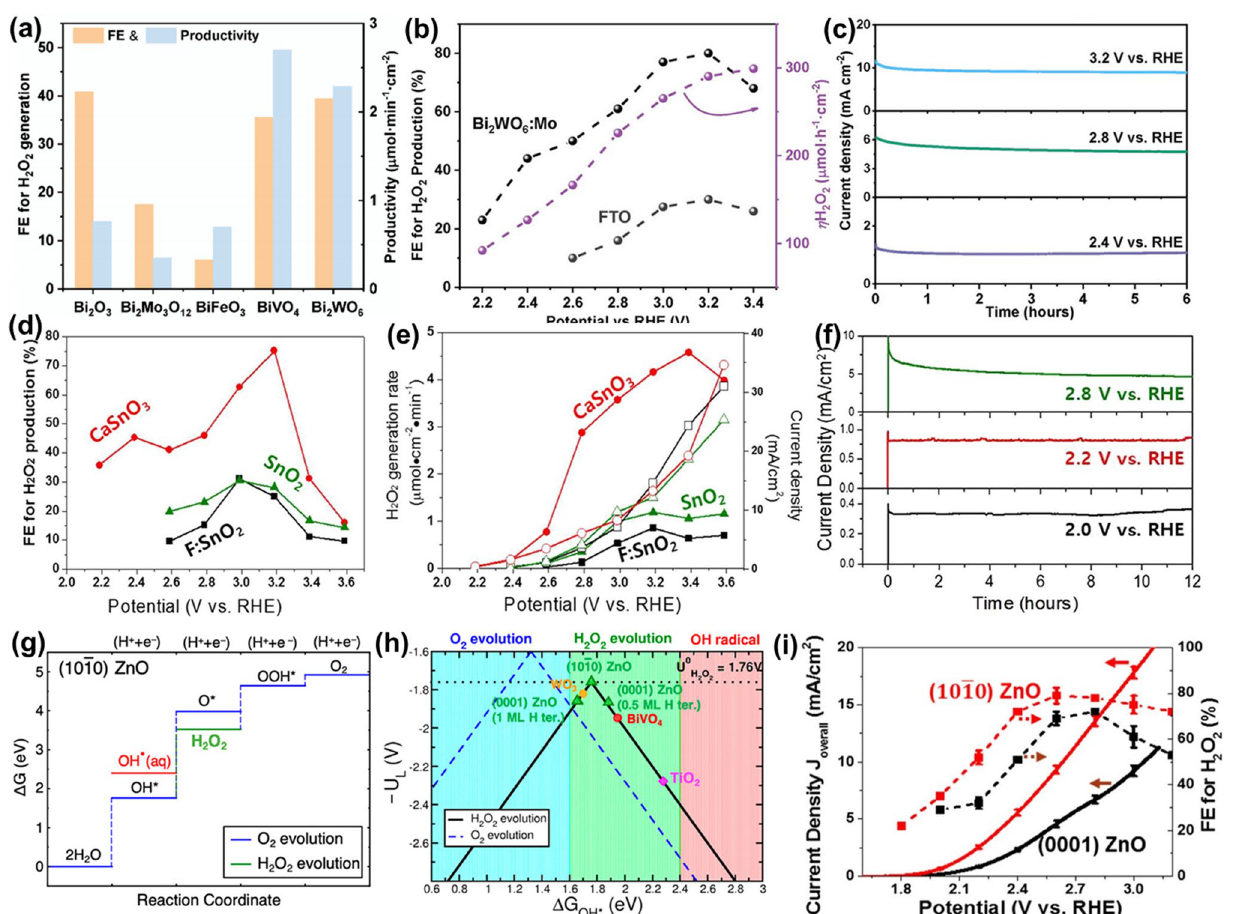
Fig. 19 a Faradaic efficiencies (FEs) and productivity of Bi-based oxides at 2.6 V RHE . b FE and H 2 O 2 generation rate of a FTO/Bi 2 WO 6 :5%Mo electrocatalyst at various potentials. c Stability measurement of a FTO/Bi 2 WO 6 :5%Mo electrocatalyst under different potentials. Reproduced with permission from Ref. [265]. Copyright 2020 Wiley–VCH GmbH. d FE, H 2 O 2 generation rates and e the densities of different catalysts at different potentials. f Durability test of CaSnO 3 catalyst under various potentials. Reproduced with permission from Ref. [267]. Copyright 2019 1 American Chemical Society. g Free energy diagram of the WOR for the most active (10 0) ZnO catalyst. h Volcano plots of 4e − WOR to O 2 and 2e − WOR to H 2 O 2 as a function of OH* binding free energies (Δ G OH* ). i Overall current density and FE for H 2 O 2 . Reproduced with permis- sion from Ref. [268]. Copyright 2019 American Chemical